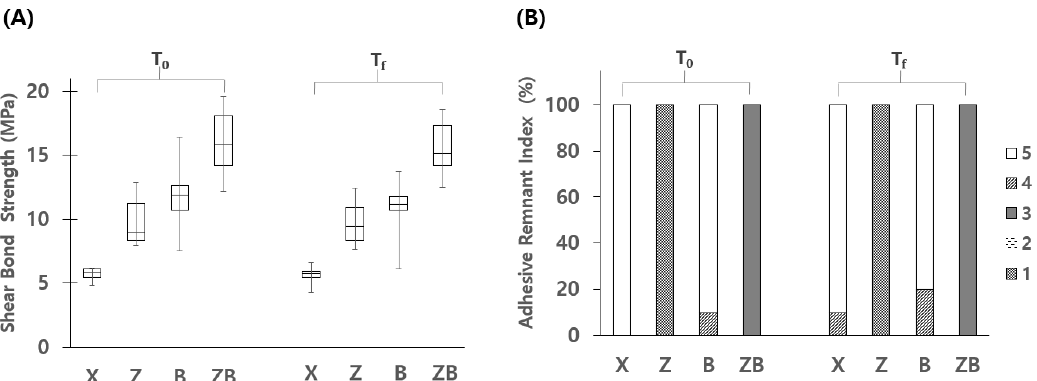
Figure 3. Results of SBS and ARI. ( A ) Comparison of SBSs at T 0 and T f . ZB showed the highest while X showed the lowest. ( B ) Comparison of modified adhesive remnant index (ARI) scores before (T 0 ) and after (T f ) the thermocycling.